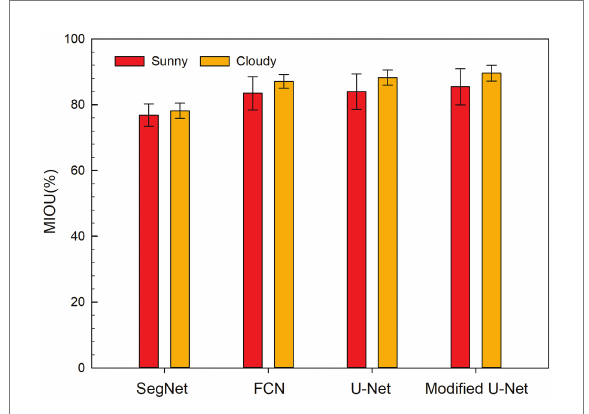
FIGURE 7 MIOU of different models under different weather